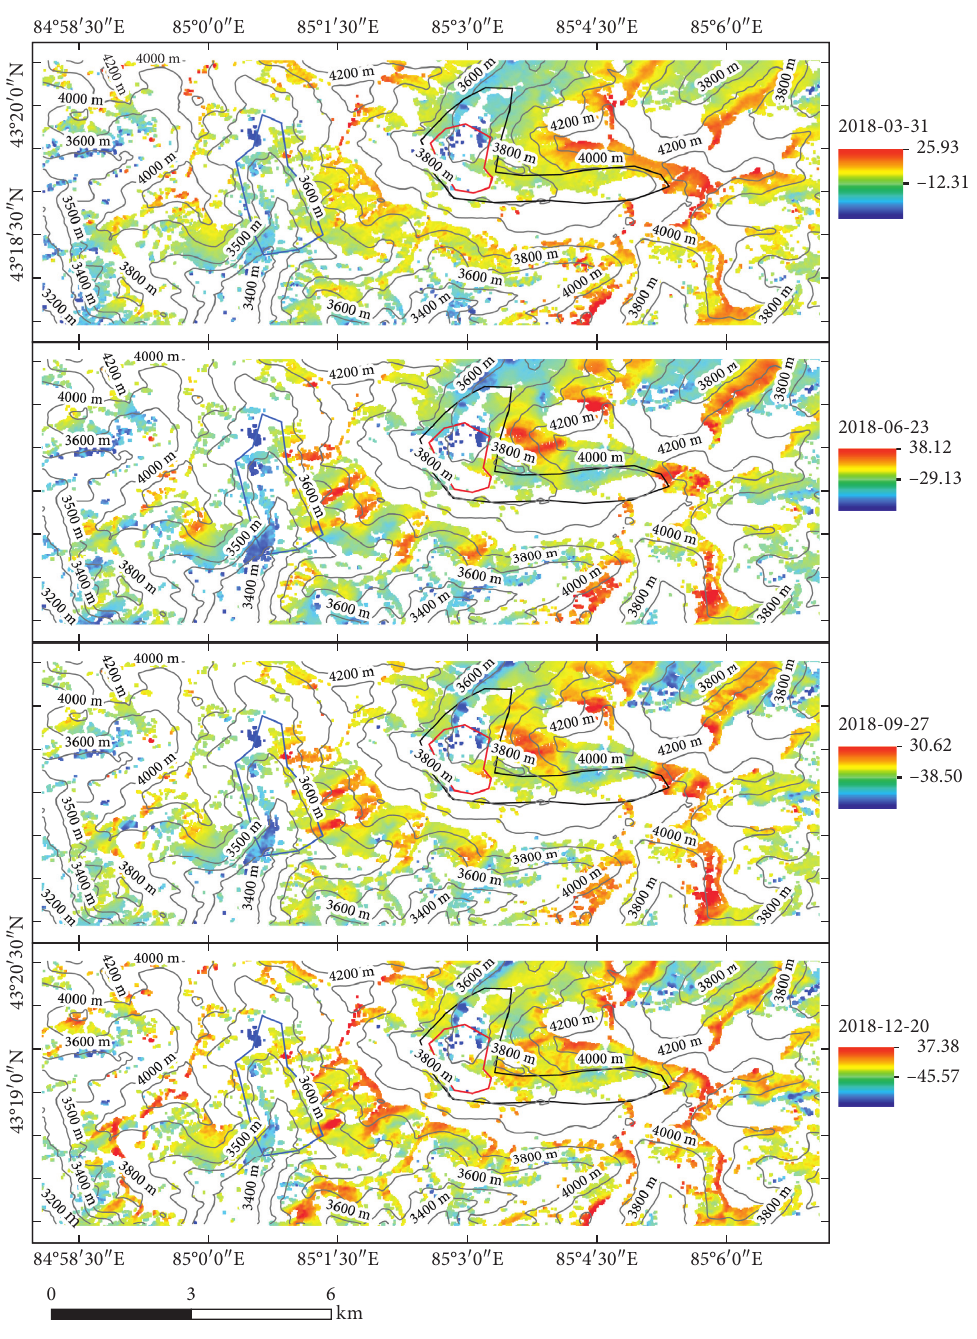
Figure 8: LOS deformation of 2018, in